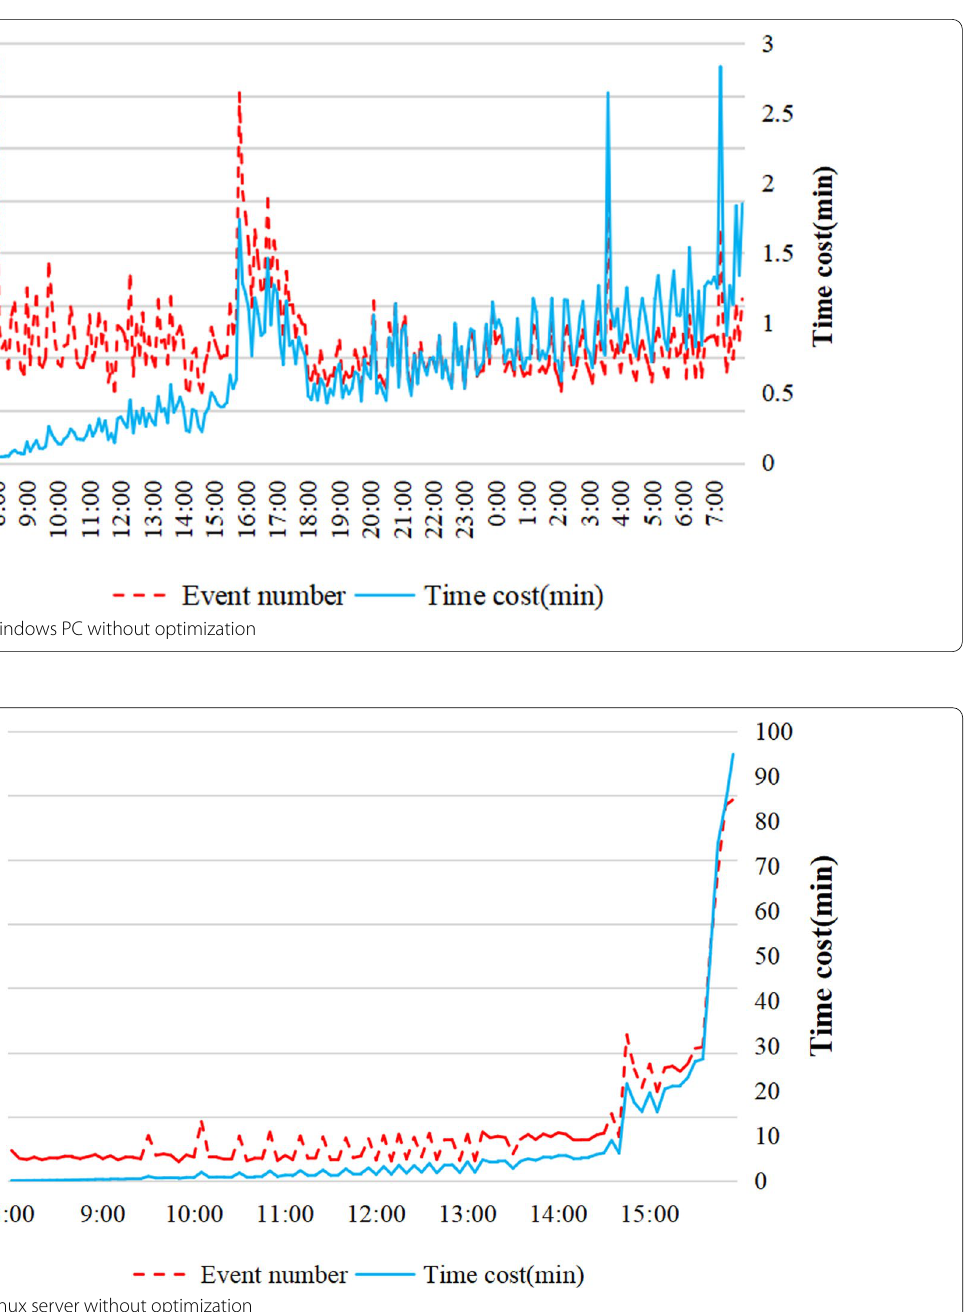
Table 8 are mainly based on the offline DARPA dataset, and also include the results of the 1-day online Windows PC and Linux Server.